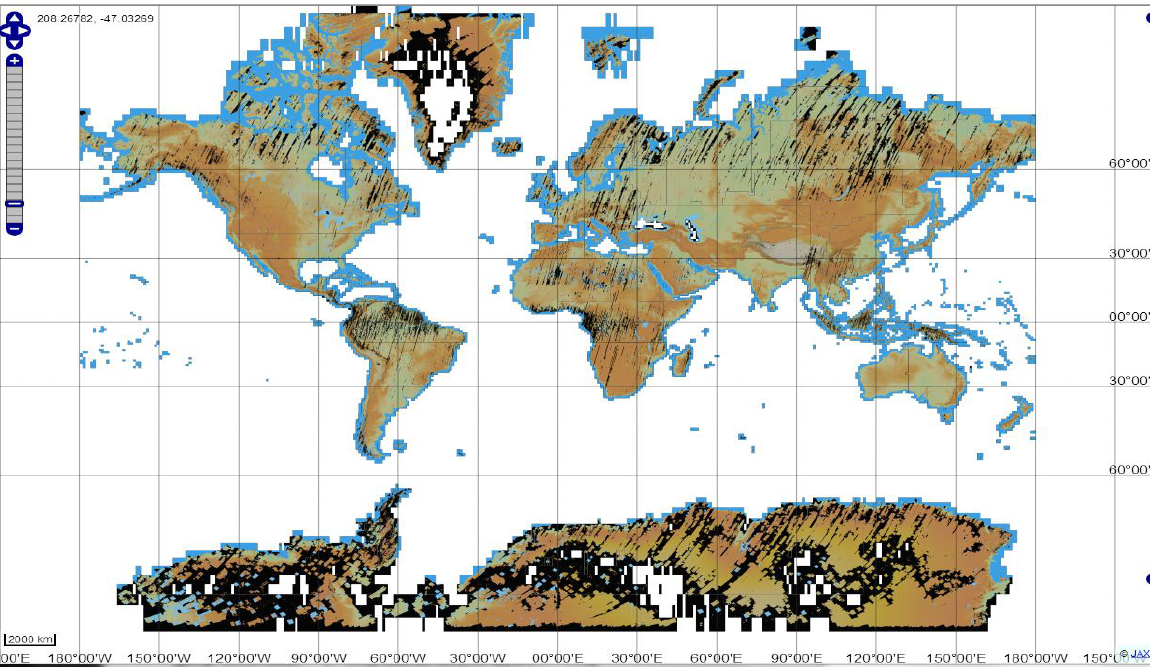
Figure 4. The browse image of AW3D global DSM data (as of March